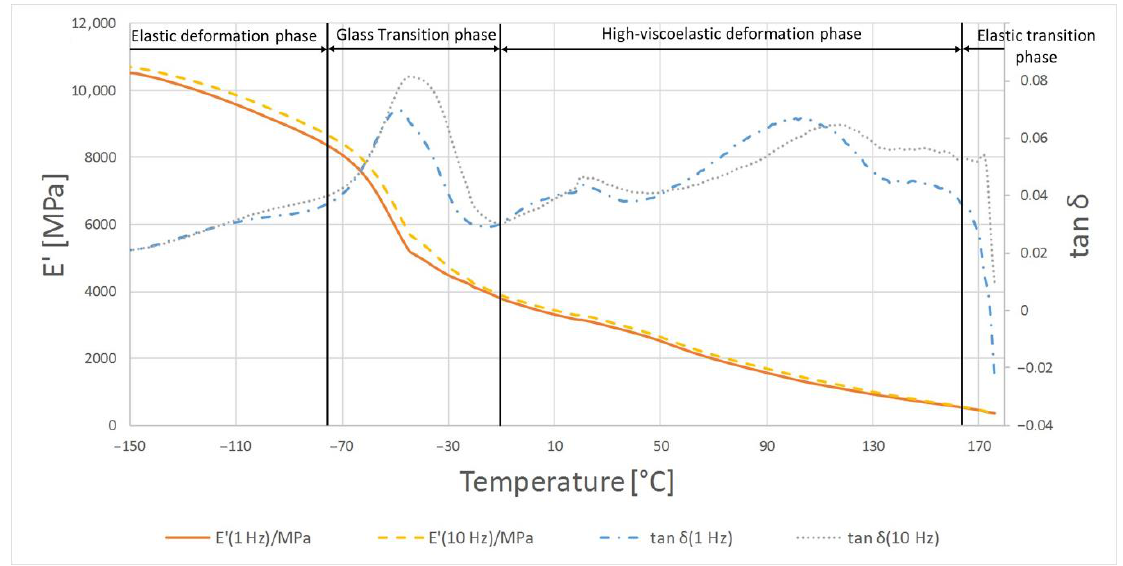
Figure 9. The results of DMTA test for PVDA Tecaflon after heat treatment.